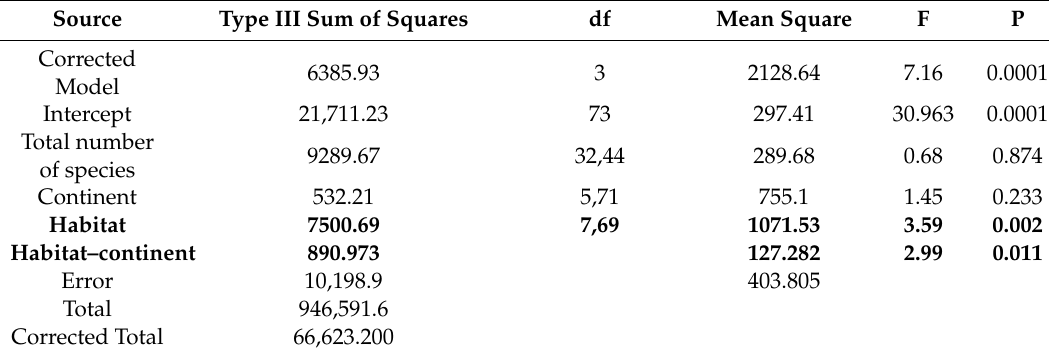
Table 7. Results of the Generalized Linear Model (GLM) regarding the probability of an increase of the frequency of venomous species within snake communities in relation to the various factors analyzed in the present study. The significant e ff ects are indicated in bold.